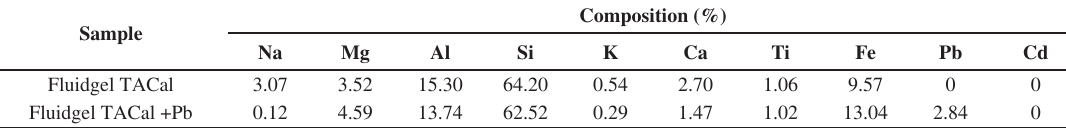
Table 7. Chemical composition by EDX. Sample